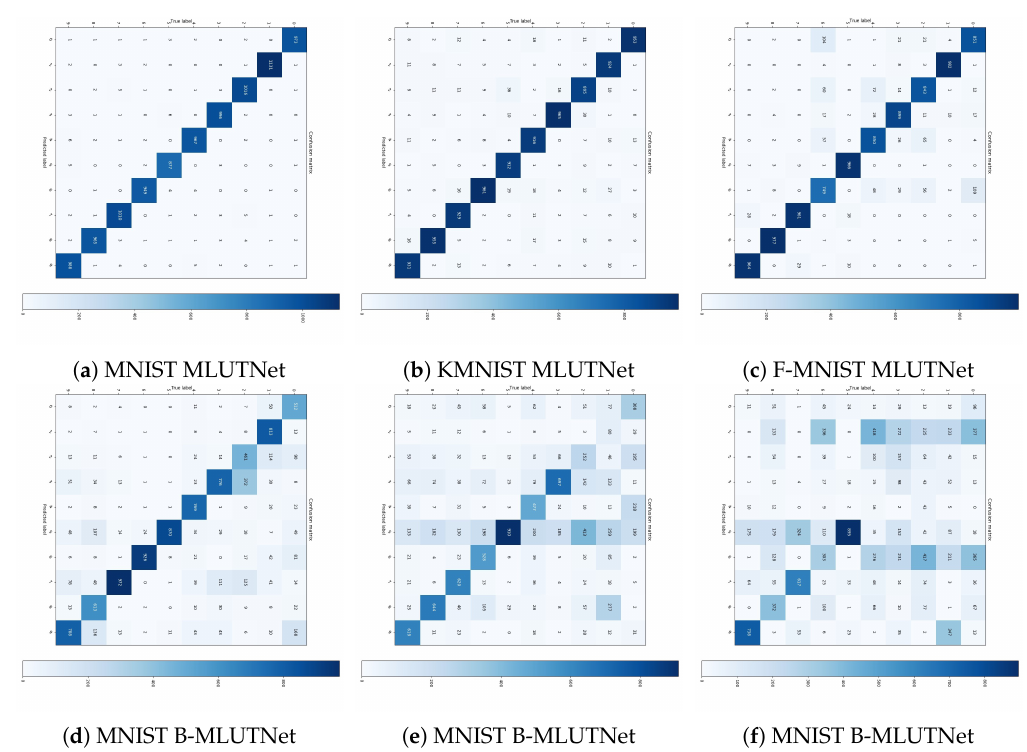
Figure 5. Performance on MNIST series datasets.